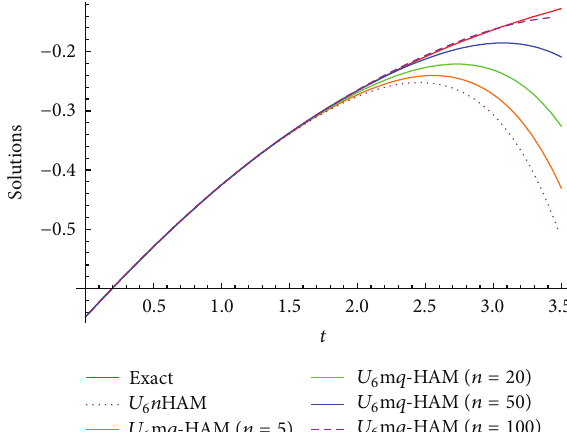
Figure 11: Comparison between 𝑈 6 of 𝑛 HAM (m 𝑞 -HAM; 𝑛 = 1) and 𝑈 6 of m 𝑞 -HAM ( 𝑛 = 5, 20, 50, 100) with exact solution of (40) at 𝑥 = 1 with (ℎ = −1, ℎ = −4.85, ℎ = −18.55, ℎ = −43.11, ℎ = −79.5) ,